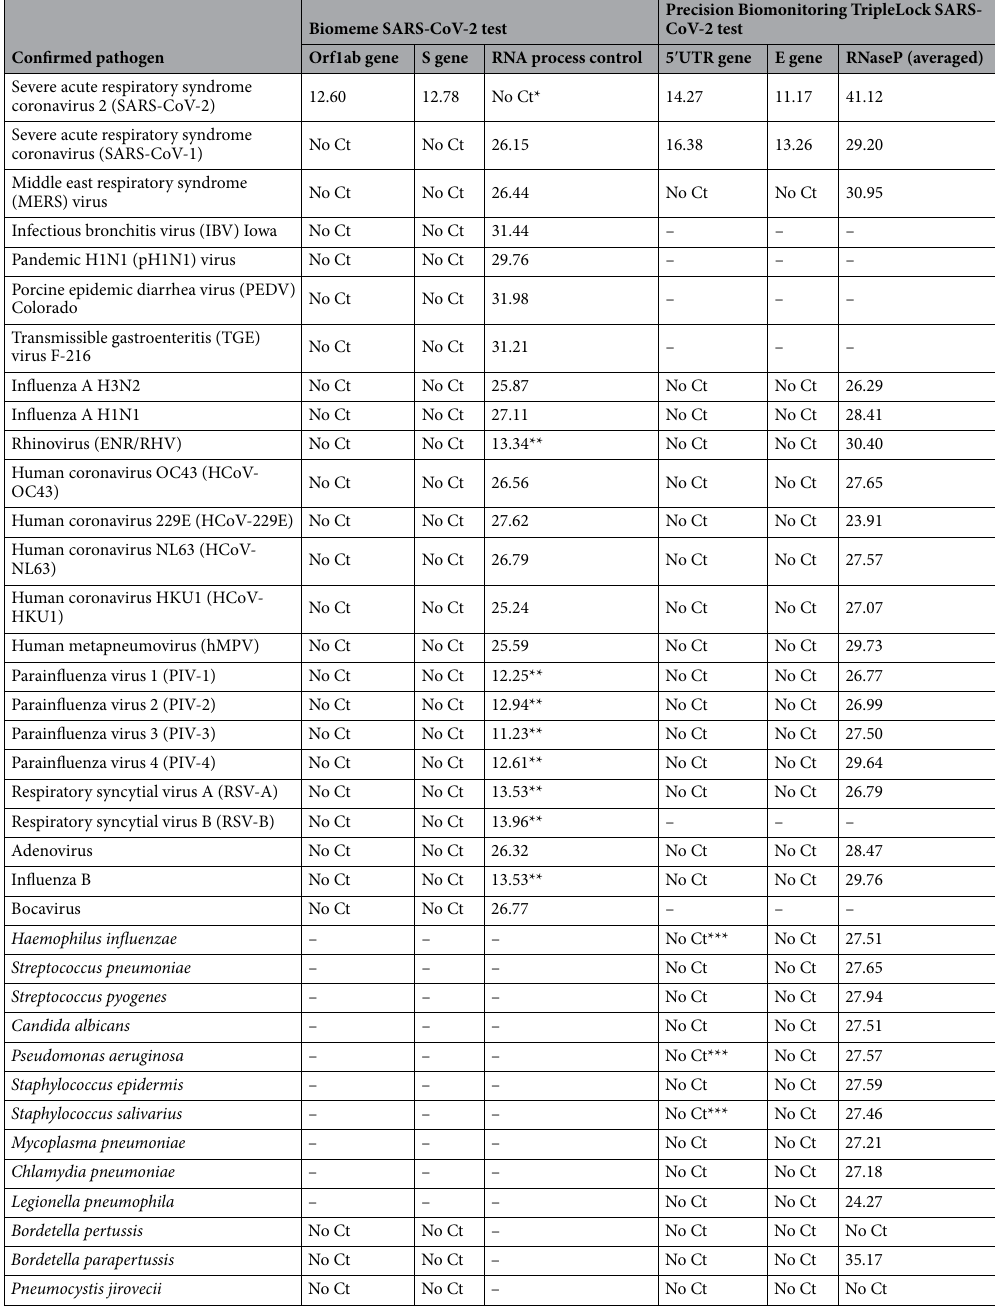
Table 2. The specificity of the Biomeme and Precision Biomonitoring SARS-CoV-2 tests. The RNA from seven different cell culture-amplified coronaviruses was used to set up the Biomeme SARS-CoV-2 assay on Biomeme Franklin three9 in order to assess the specificity of the test to SARS-CoV-2. Mid-turbinate swabs from common respiratory pathogens were also used to test for cross-reactivity with both the Biomeme and Precision Biomonitoring SARS-CoV-2 tests. Common bacteria were also tested with the Precision Biomonitoring assay, not the Biomeme test. *According to the Biomeme SARS-CoV-2 test design, the RNA Process Control may not amplify (No Ct) when the two SARS-CoV-2 gene signals are very strong. **RNA used was previously extracted for use on xTAG RVP FAST v2 (Luminex, Toronto, Canada) or ResPlex II (Qiagen, Hilden, Germany), which both use MS2 as an internal control, hence much lower Ct values. ***Threshold of 500 RFU was not met, Ct value